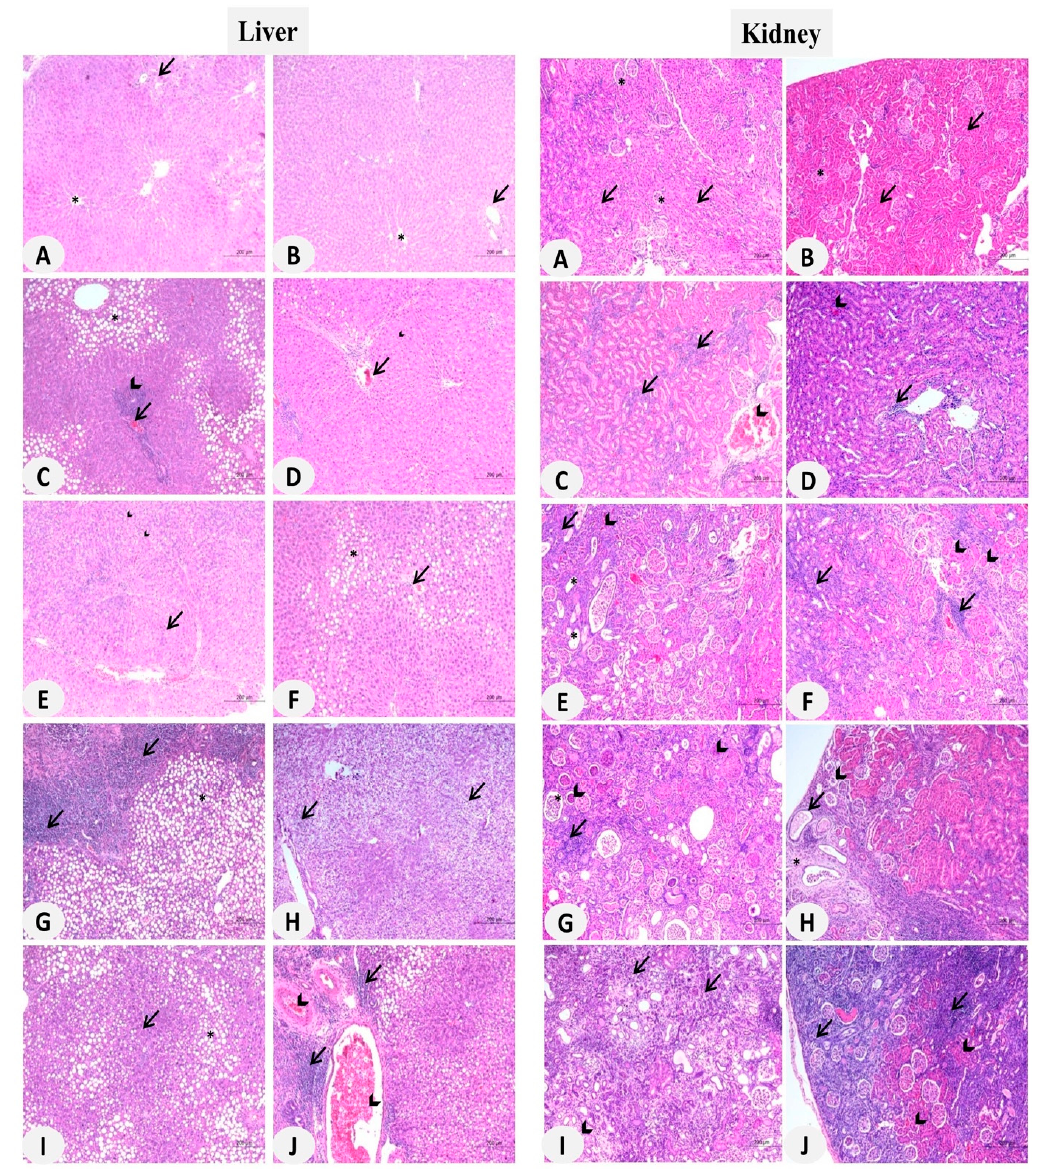
Figure 2. MSNs-induced histological alteration in the liver and kidney of rats. (Left panel) Photomicrographs of liver sections of ( A,B ) control group showing normal hepatic lobule, central veins (*), and portal area (arrows), ( C,D ) rats received 25 mg/kg MSNs showing moderate fatty changes of hepatocytes (*), mild leukocyte infiltration in portal areas (arrow head), congestion (arrow) ( C ), degenerative changes, proliferation of Kupffer cells (KCs) (arrow heads) and leukocyte infiltration in the portal area (arrow) ( D ), ( E,F ) rats received 50 mg/kg MSNs showing degenerative changes of hepatocytes (arrows), proliferation of KCs (arrow heads) ( E ), fatty changes of hepatocytes (*), leukocyte infiltration and congestion (arrow) ( F ), ( G,H ) rats received 100 mg/kg MSNs showing fatty changes (*), leukocyte infiltration (arrows) ( G ), and vacuolar degeneration (arrows) ( G ), and ( I,J ) rats received 200 mg/kg MSNs showing fatty changes (*), necrosis (arrows) ( I ), leukocyte infiltration (arrows) and congestion (arrow heads) ( J ). (Right panel) Photomicrographs of kidney of ( A,B ) control group showing normal glomeruli (*) and renal tubules (arrow head), ( C,D ) rats received 25 mg/kg MSNs showing interstitial inflammatory cell aggregates (arrows), congestion (arrow head) ( C ), perivascular inflammatory cell aggregates (arrows) and congestion (arrow head) ( D ), ( E,F ) rats